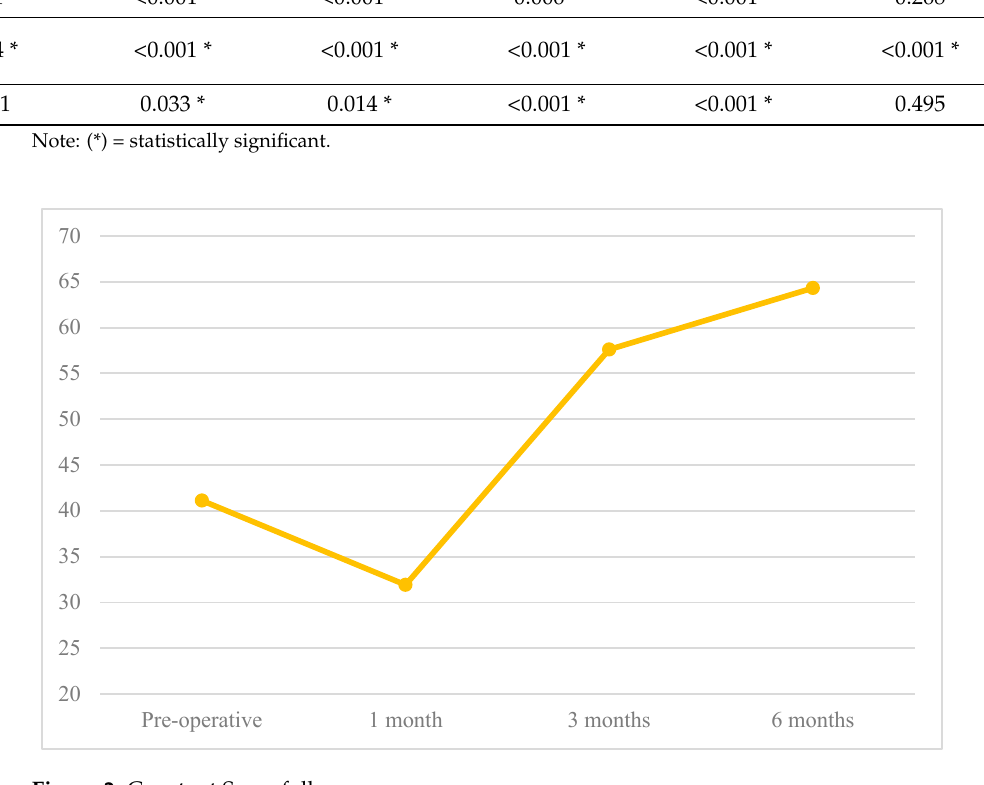
Figure 2. Constant Score follow-up.